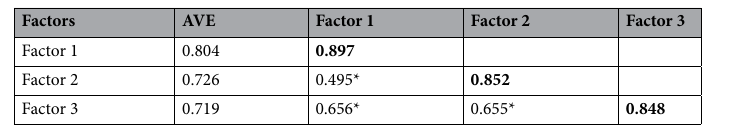
Table 4. Factors discriminability (n = 206). Factor 1, Inner sense of temporality and future; Factor 2, Interconnectedness with self and others; Factor 3, Inner positive readiness and expectancy; AVE, Average variance extracted; *Correlation is significant at the 0.01 level (2-tailed); The bold is the square root of the AVE.